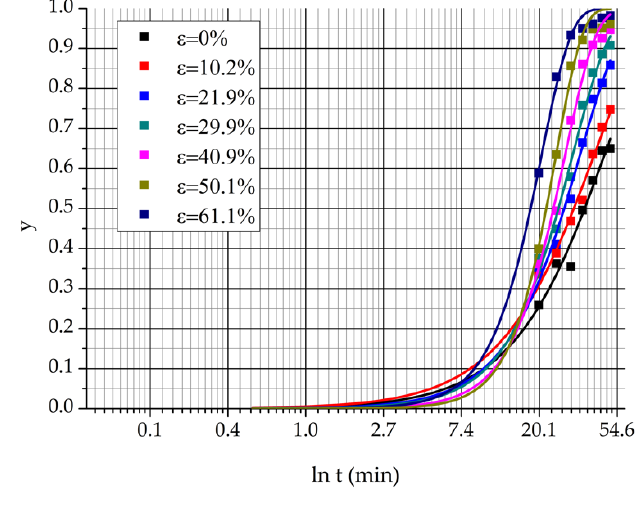
Figure 17. Avrami Figure 17. Avrami curves.